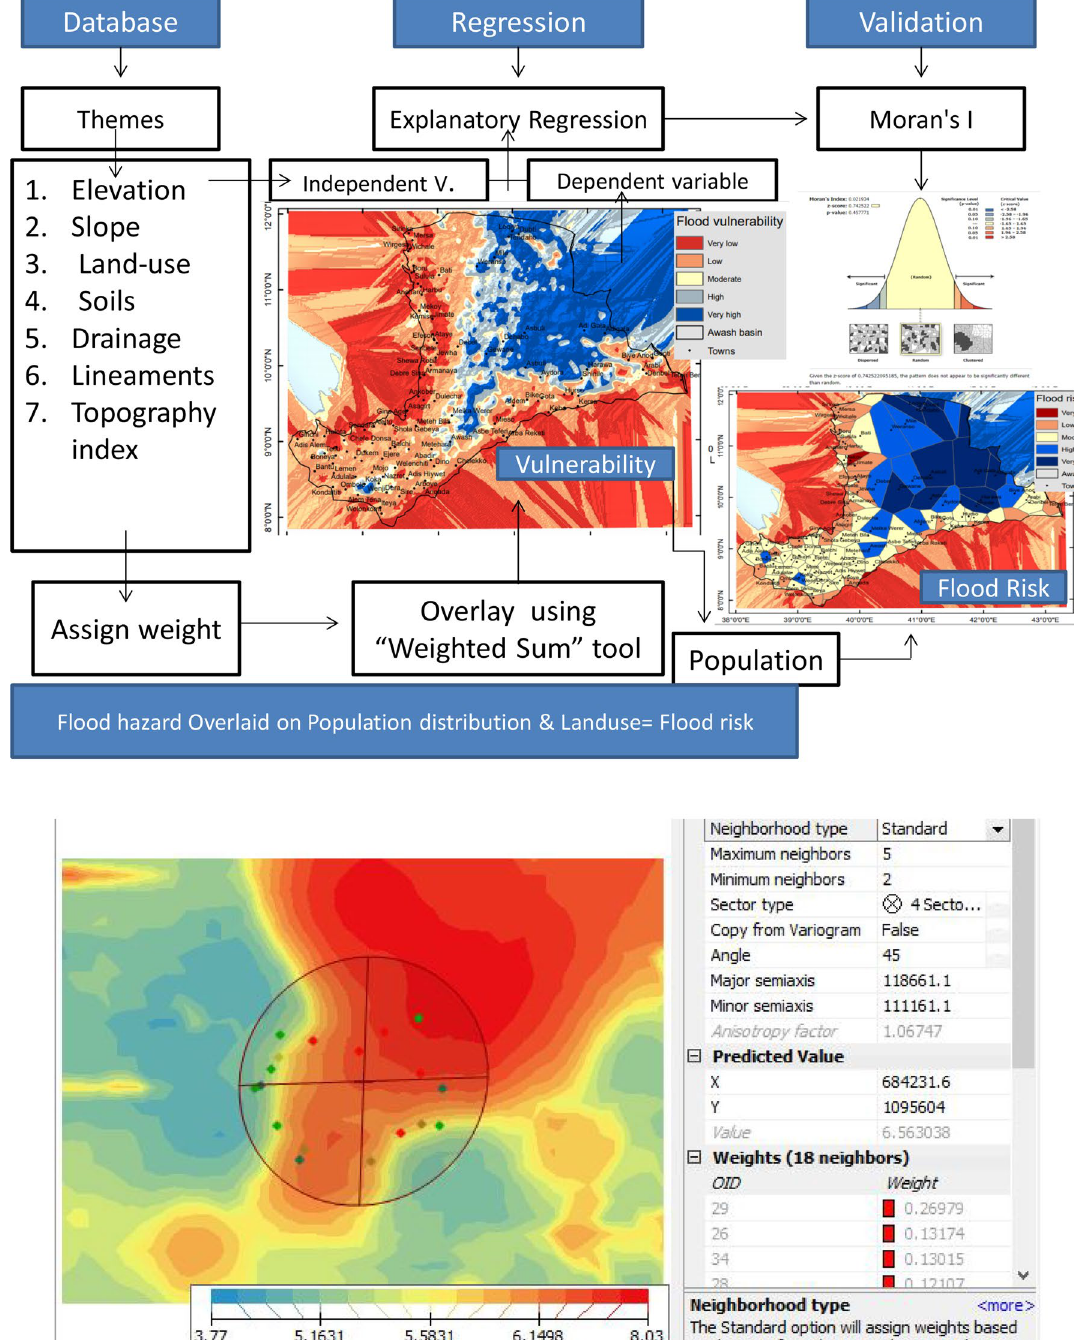
Figure 2. Methodology employed. This figure was created using ArcGIS 10.3.1